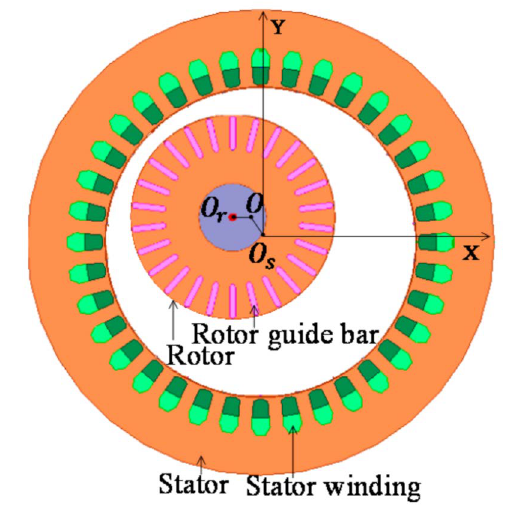
Figure 1. Mixing